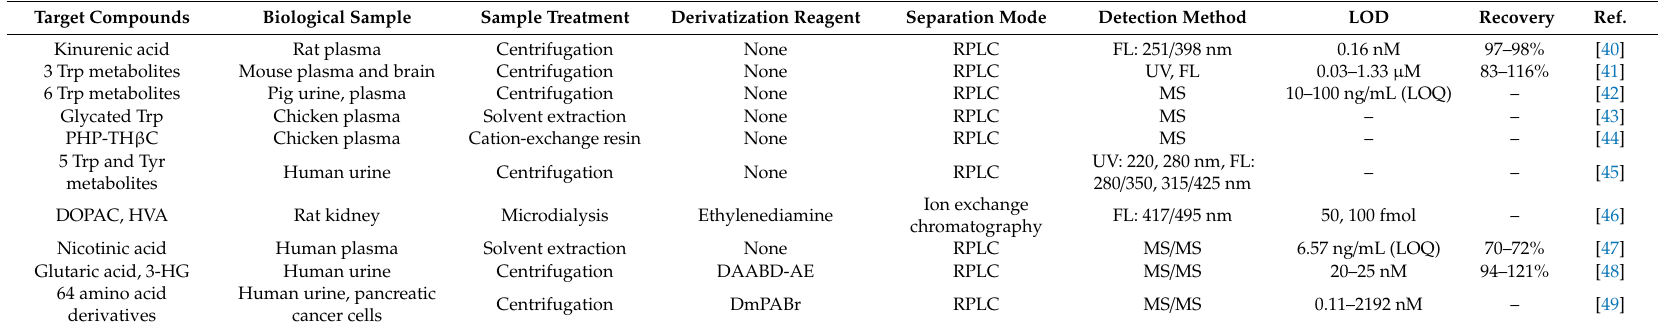
Table 3. Analytical methods for amino acid metabolites in biological